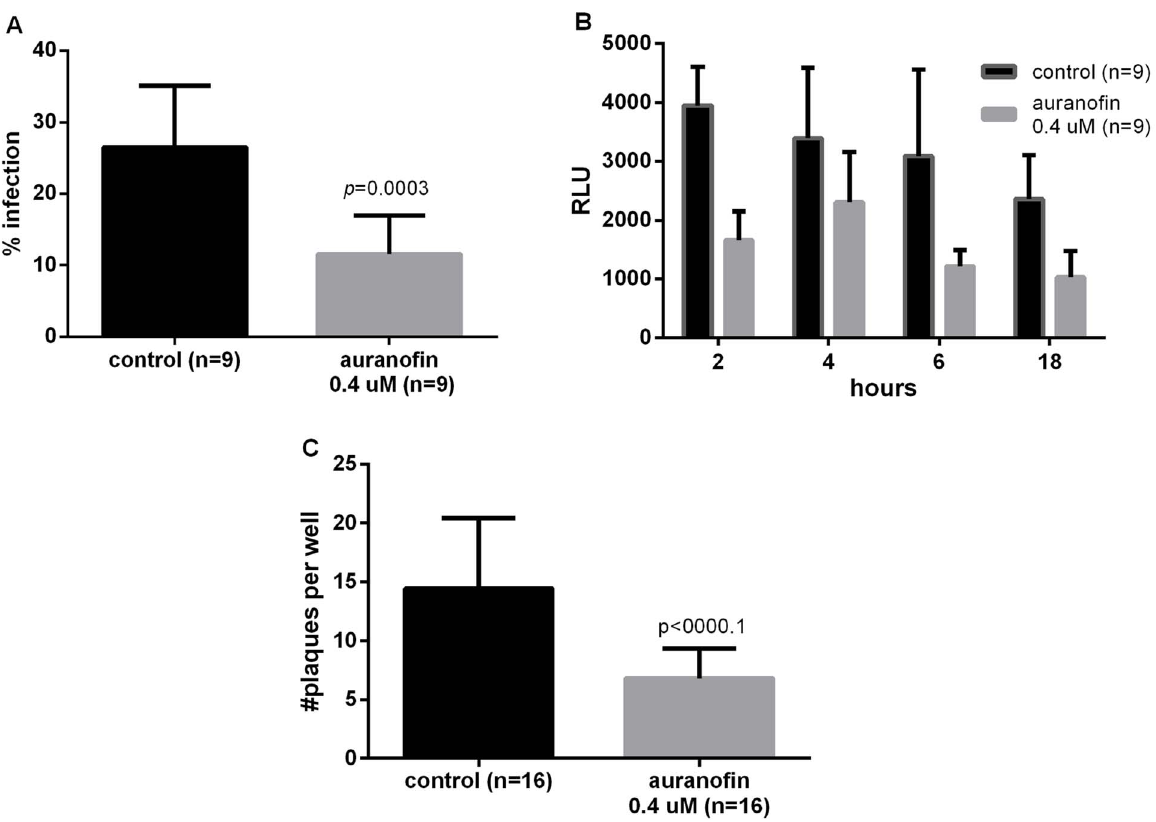
Figure 2. Effect of auranofin on parasite viability and plaque formation. A. Auranofin significantly decreased the rate of infection after 24 hrs (three independent experiments were conducted with triplicates, and at least 100 cells were counted. The number of infected cells was determined per each high power field by light microscopy. The percentage of infection was calculated as the total number of infected cells divided by the total number of cells multiplied by 100). B. Viability of extracellular tachyzoites in complete medium at 18 hrs (overnight) using ATP assay. RLU: relative luminescence units. C. The number of plaques observed at day 7 post infection was significantly different. Observations from 3 independent experiments are presented (n=total number of observations). Data presented as mean 6 SD.